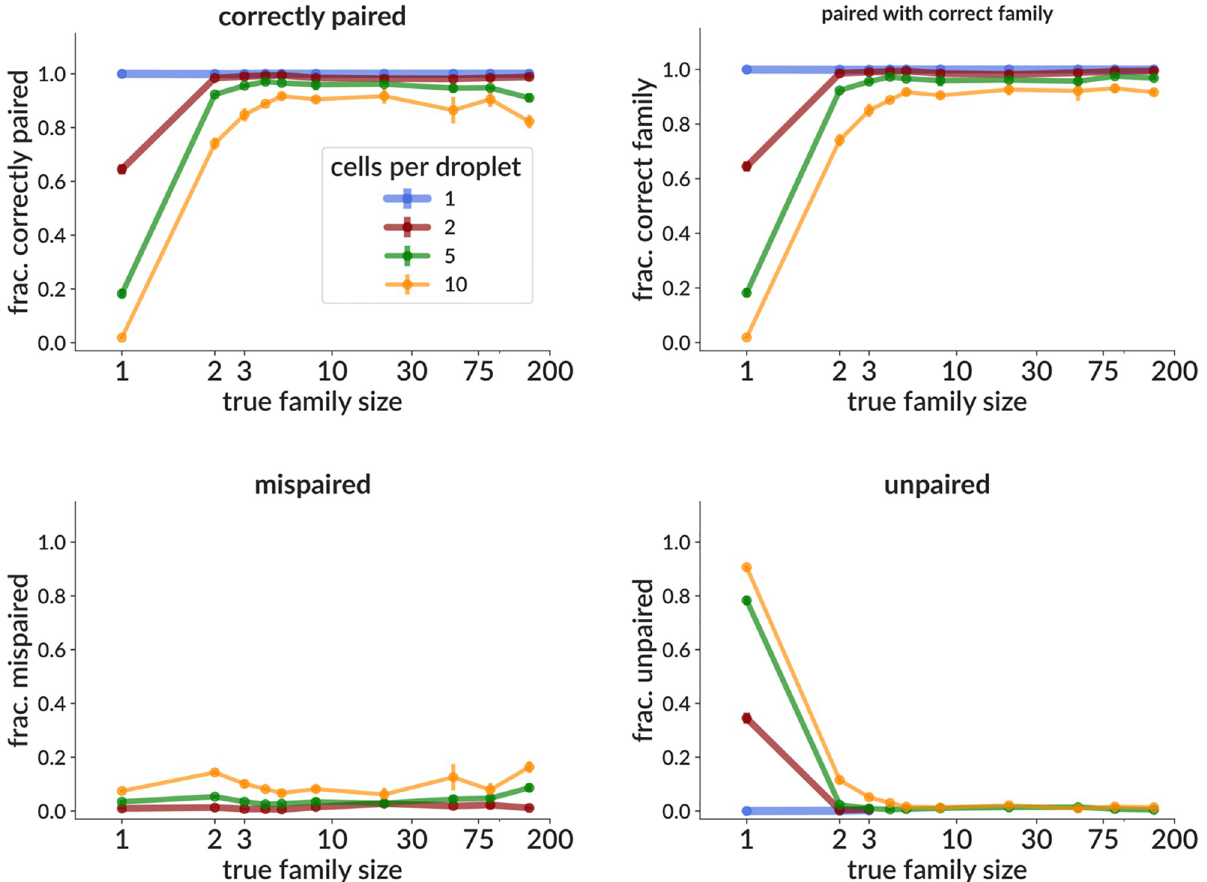
Fig 4. Effectiveness on simulation of the pair info cleaning method as a function of true family size, shown as the fraction of sequences correctly paired (top left); and the fraction not correctly paired, split into those mispaired (bottom left) and left unpaired (bottom right). We also show the fraction that are paired with a sequence from the correct family, though not necessarily the correct sequence from that family (top right). Each point is the mean ( ± standard error, often smaller than points) over three samples, each consisting of 3,000 simulated rearrangement events (around 12,000 total heavy and light sequences). The family sizes are drawn from a distribution inferred from real data. The effects of a variety of cluster size distributions on performance are shown in S8 Fig, in terms of both fraction correctly paired and of final clustering